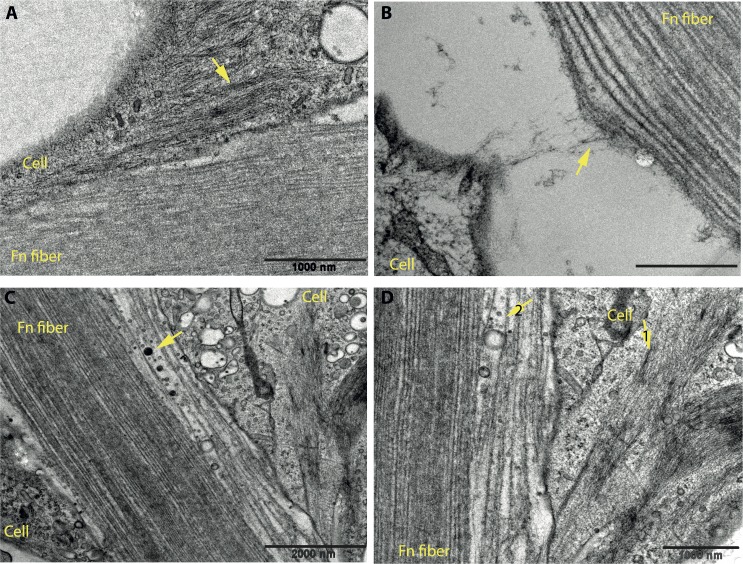
The interface between outgrowing HUVEC and Fn fibers reveals close and active interactions.Samples were prepared as described for Fig 4, they were fixed with formaldehyde and embedded in Epon. 60 nm sections were observed with TEM. Four instances of a cell-fiber interface are shown (A-D). Scale bar: 1000 nm for A, B and D and 2000 nm for C.